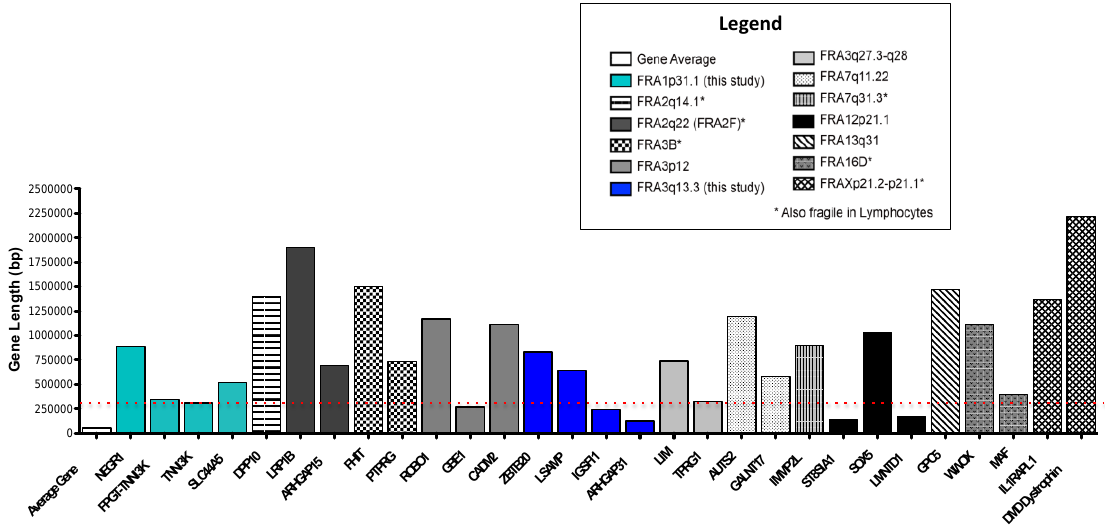
Figure 3. Genes contained within CFSs were found to be longer than the average human gene. Genomic locations of all CFSs experimentally characterized in fibroblasts were defined and all genes mapping to the CFS regions were identified. The gene length is plotted. The plotted average human gene length (first bar) was derived by dividing the sum of the length of all annotated human genes divided by the total gene number. The red line indicates a previously reported > 300 kb cut off for long genes associated with CFSs [13].